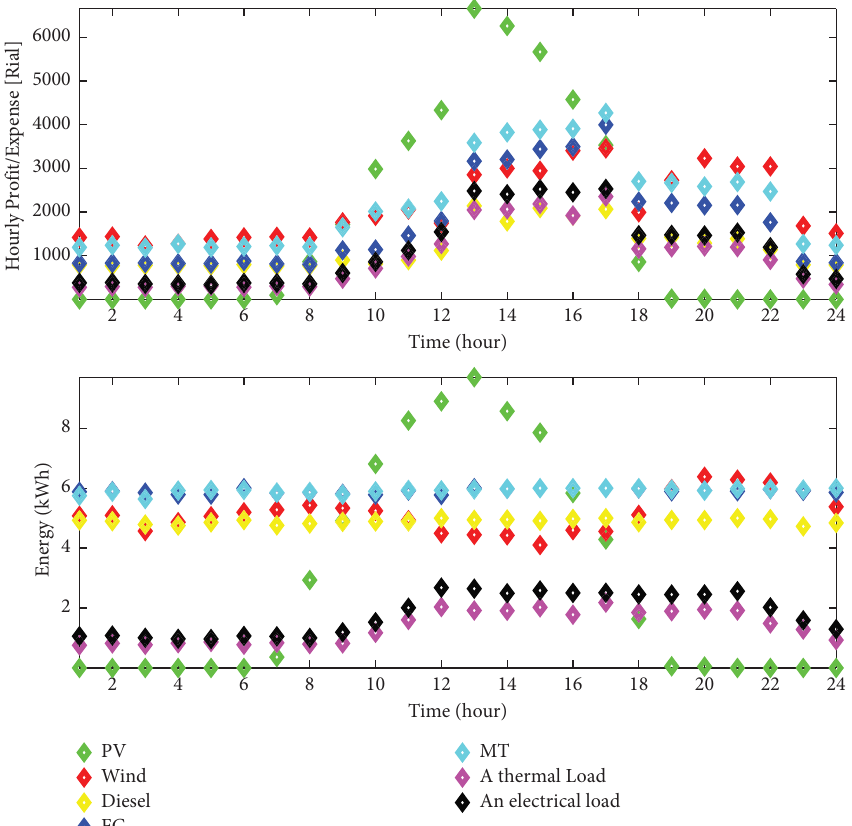
Figure 13: Average hourly proft/cost and production/consumption power of solar panel, wind turbine, diesel, fuel cell, microturbine, and thermal and electrical loads.